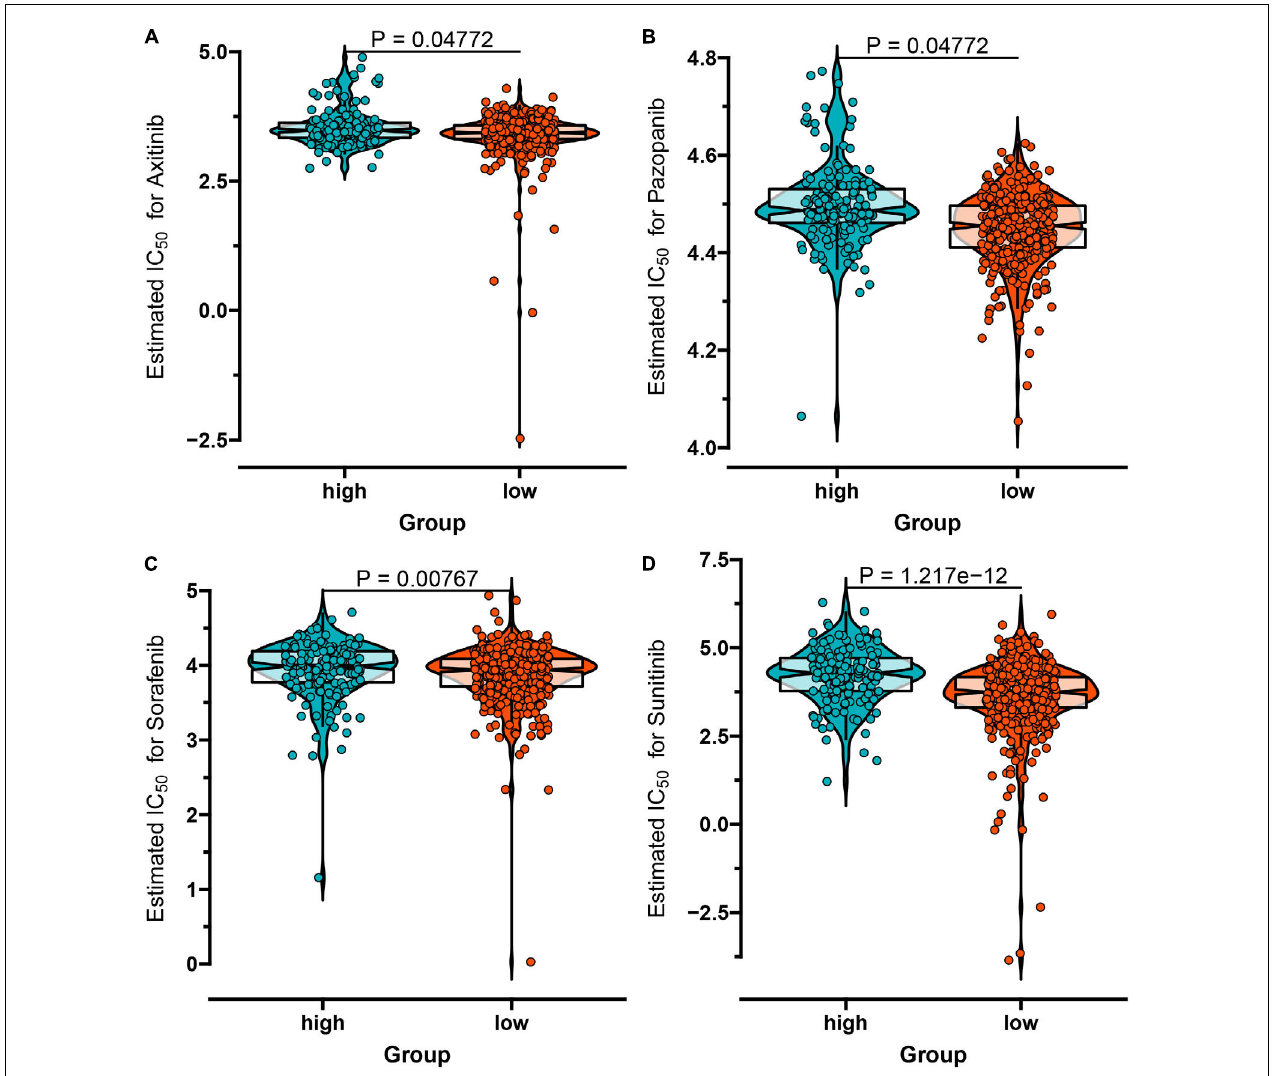
FIGURE 11 | The IC 50 values of four chemo drugs in the IR score group of ccRCC including Axitinib (A) , Pazopanib (B) , Sorafenib (C) , and Sunitinib (D)